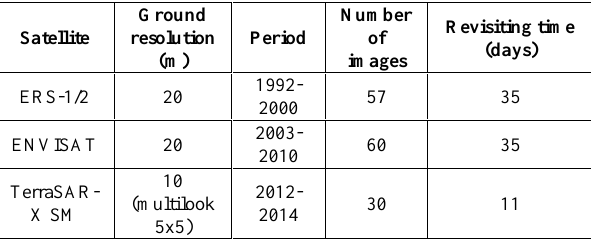
Table 1. SAR datasets available and their main features